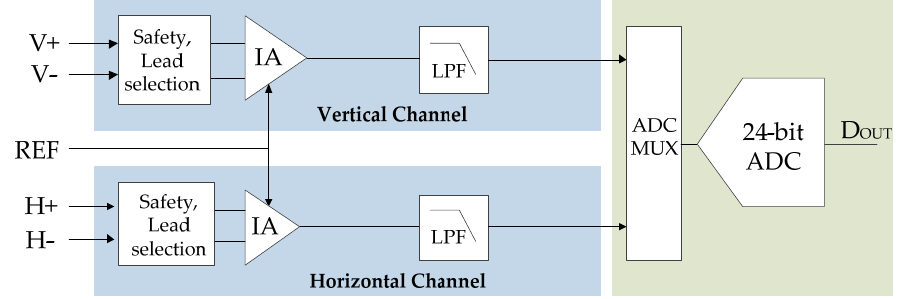
Figure 3. EOG AFE based on high ‐ resolution ADC (Sequential Sampling).